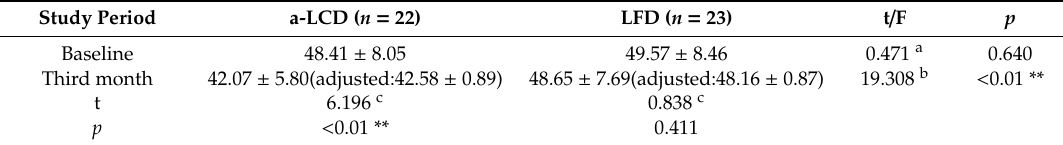
Table 6. Comparison of depression scores between the two groups.